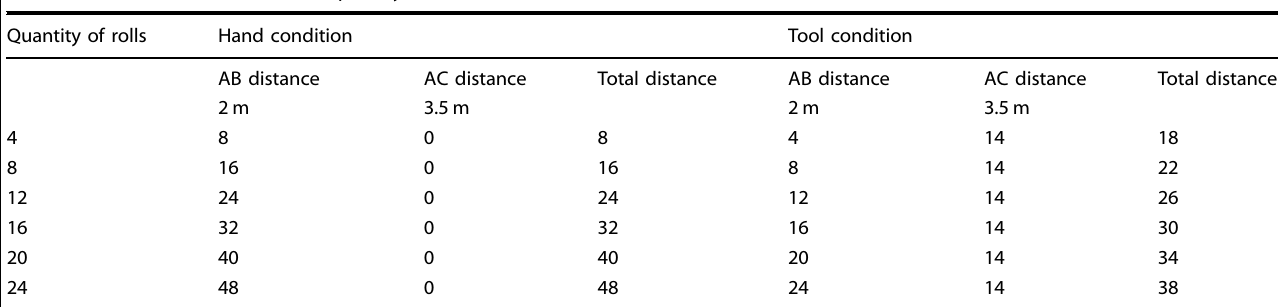
Table 3. Distance in function of the quantity of rolls and the condition. Quantity of rolls